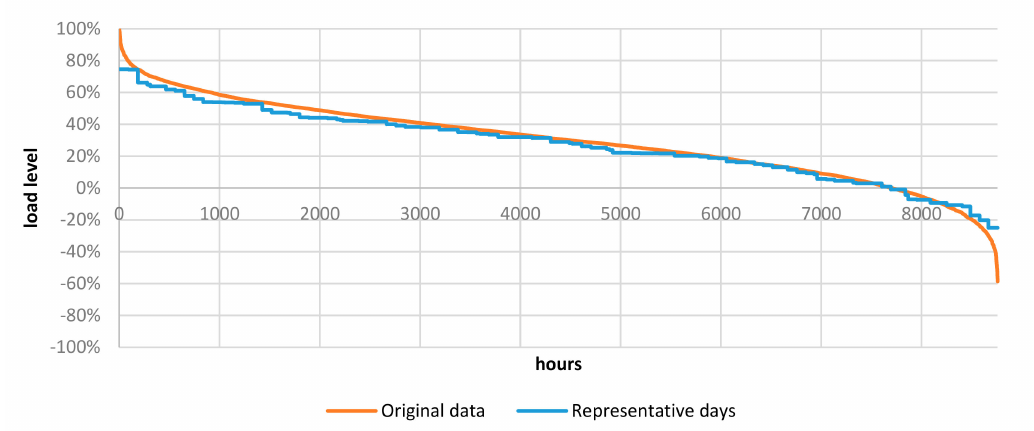
Figure 4. Levelized duration curve of residual load for the considered electricity markets with 65% renewables